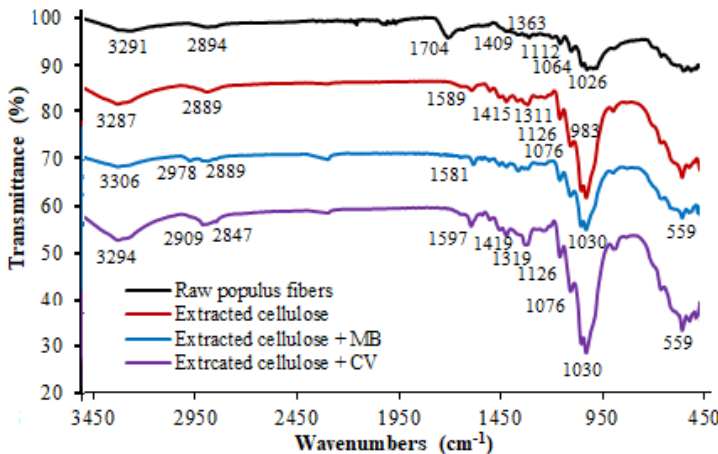
Figure 1. FT-IR spectrum of raw Populus tremula fibers and extracted cellulose before and after the adsorption of methylene blue and crystal violet (C 0 = 30 mg L −1 , Time = 30 min, T = 22 °C, dye volume = 10 mL, and adsorbent dosage = 0.012 g).